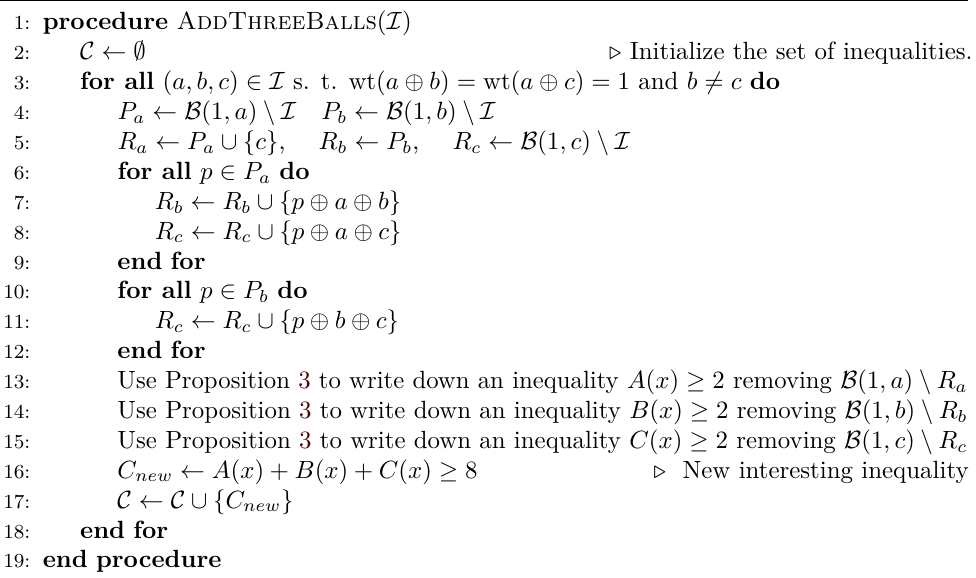
Algorithm 3 Create new inequalities from all possible triples of distorted balls